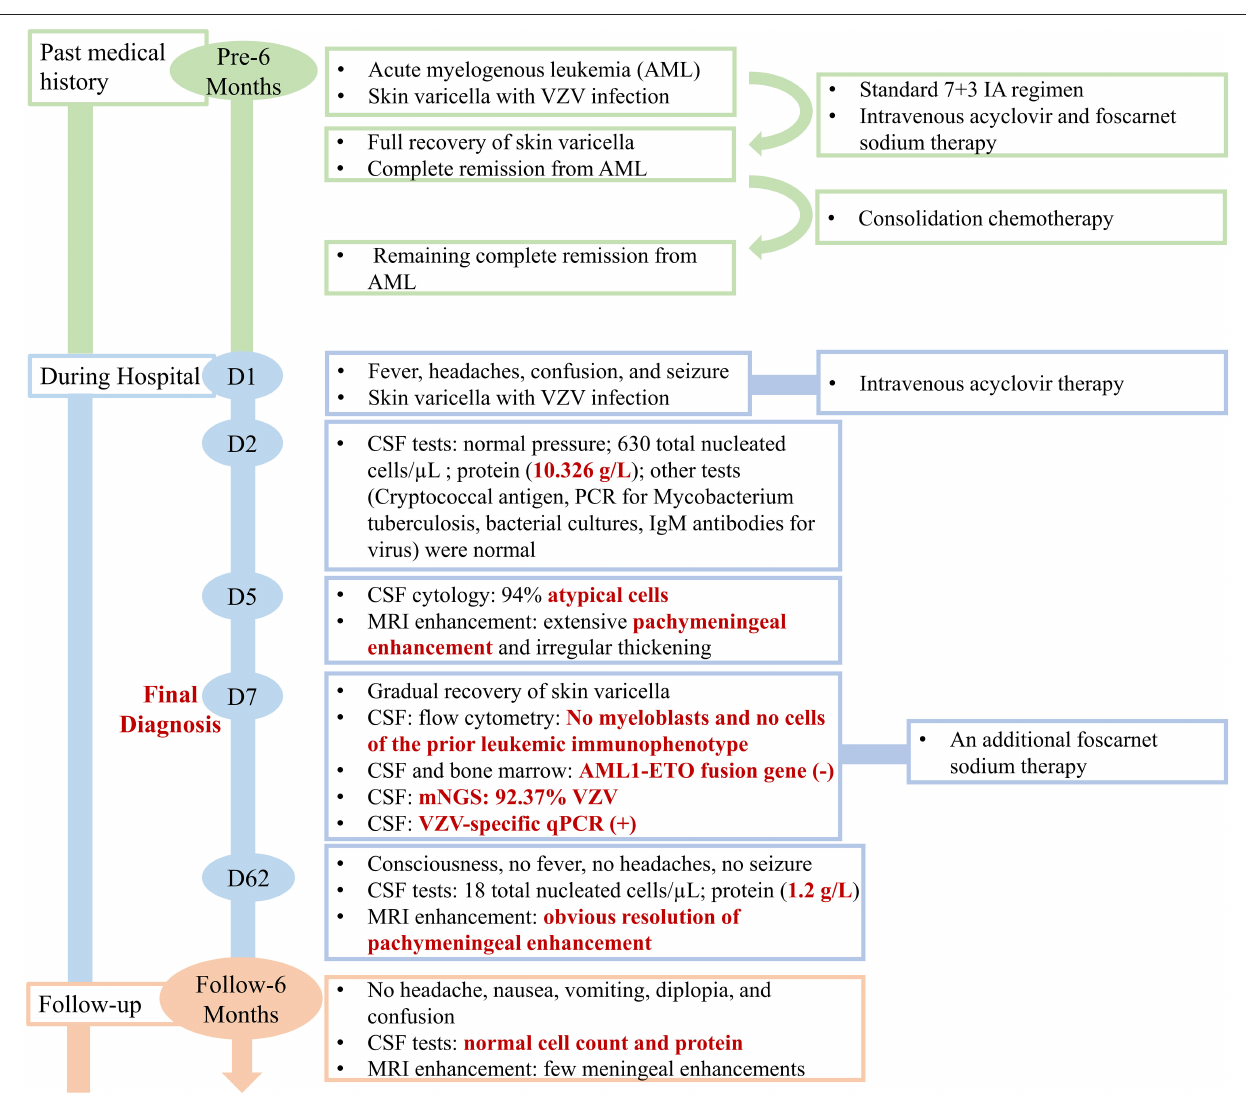
FIGURE 1 | The clinical course of the patient